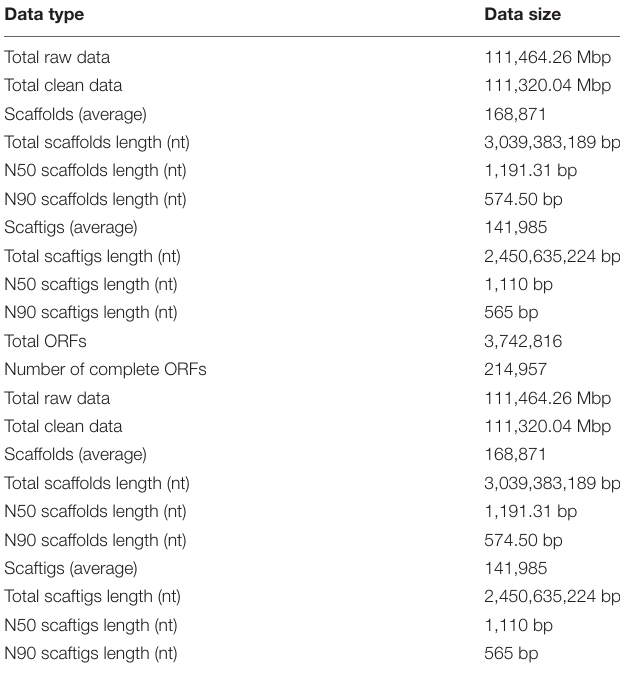
TABLE 2 | Metagenomic sequencing